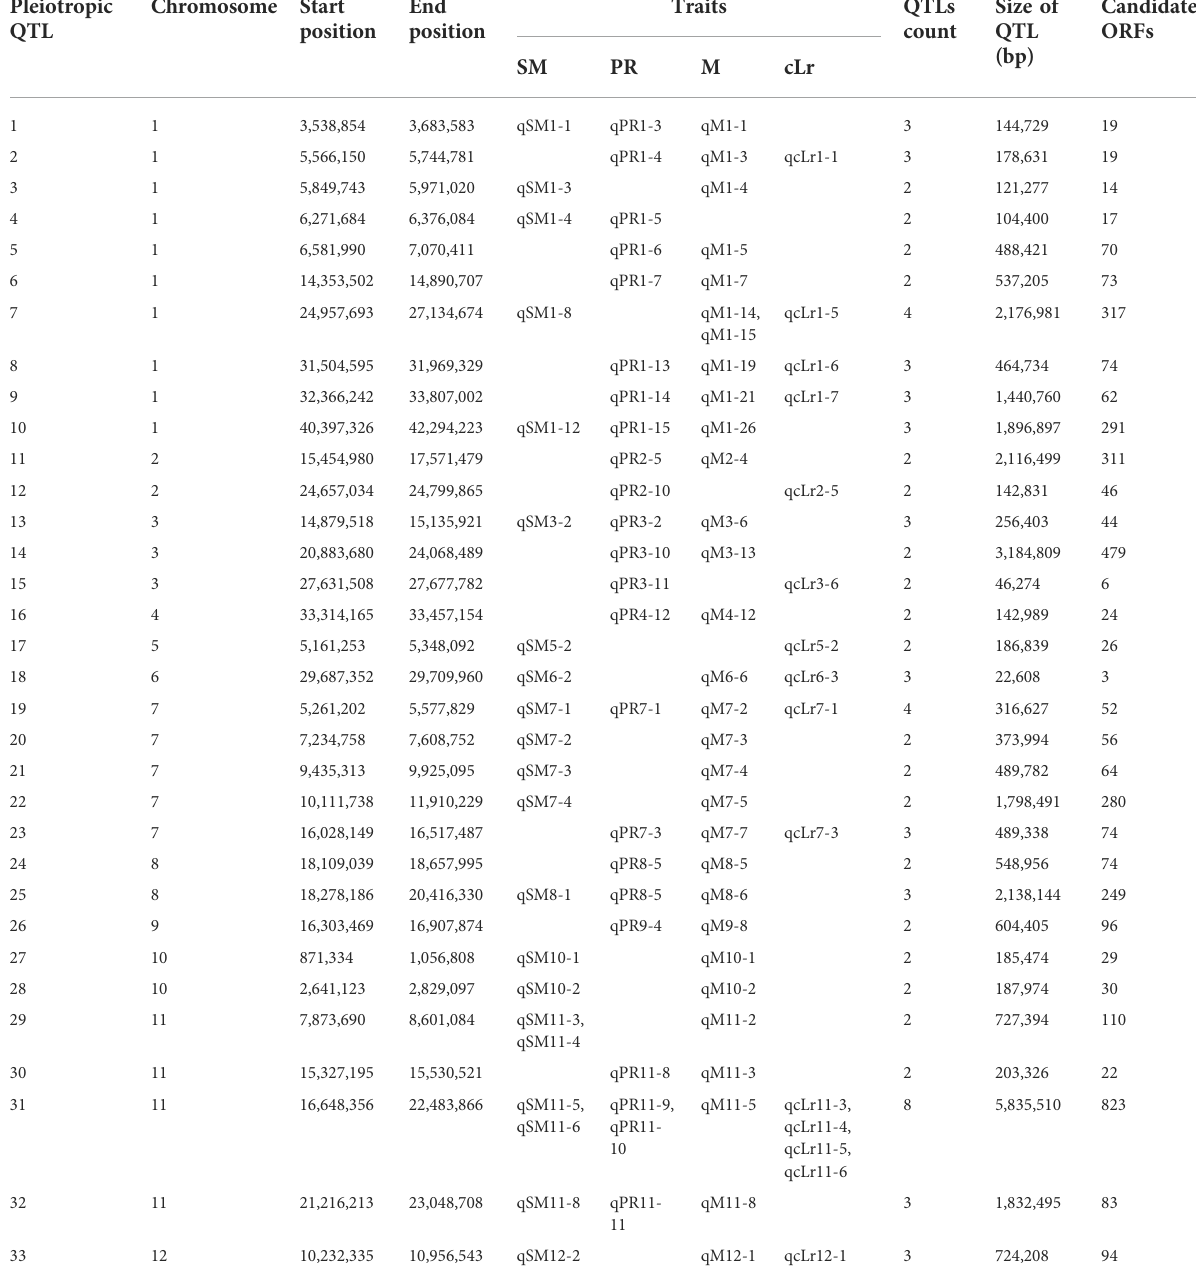
TABLE 5 List of QTLs with pleiotropic effect, situating at common QTL regions in the rice genome for lodging resistance traits. Pleiotropic Chromosome Start End QTL position position